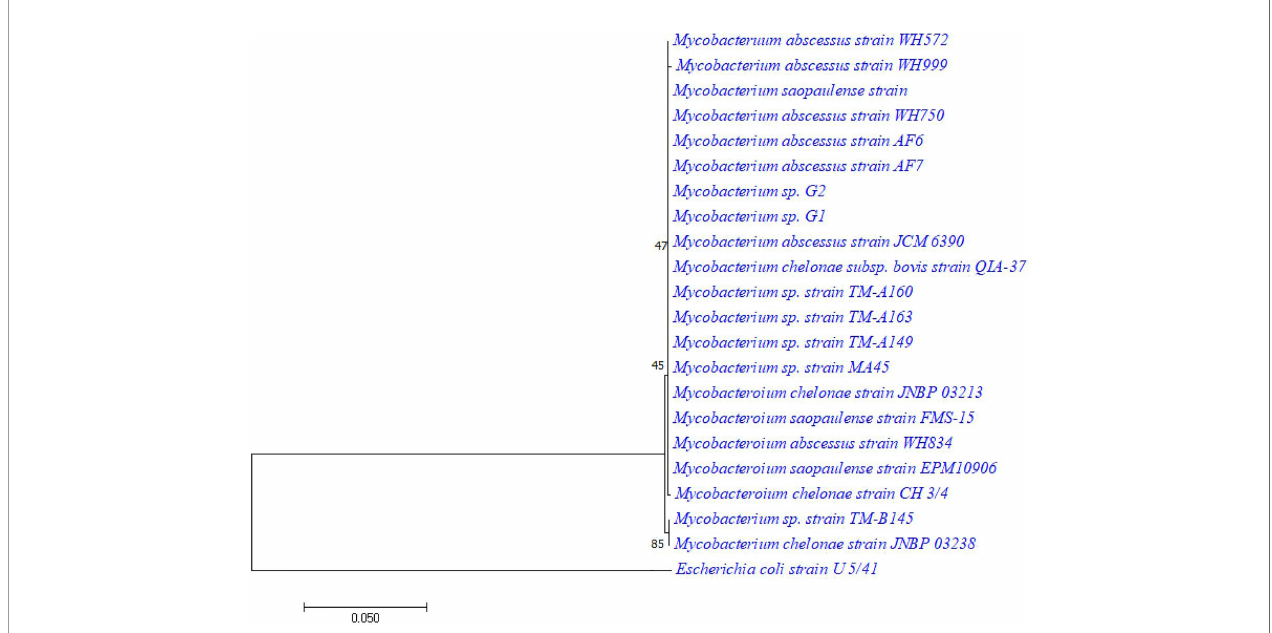
FIGURE 1 | Comparison of 16S rRNA sequences from the M. saopaulense strain with 20 other orthologous sequences. Escherichia coli was used as the root of the phylogenetic tree. The method of neighbor-joinging was used to construct the tree. The number of bootstrap replications was set to